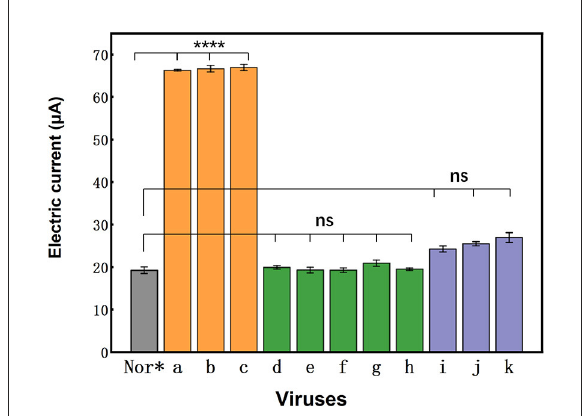
FIGURE5 Specificity of the photoelectrochemical biosensor approach to different viruses. Photocurrent responses of the universal aptasensor to 2.16 × 10 4 ffu/ml of normal NA cell (Nor*), rRC-HL (a), CVS-24 (b), GX074 (c), CSFV (d), PRRSV-5 (e), PRRSV-96 (f), PCV (g), and VSV-g (h), and photocurrent responses of the p-r-RNA aptasensor, p-w-RNA aptasensor, and p-c-RNA aptasensor to 2.16 × 10 4 ffu/ml of rRC-HL (i), CVS-24 (j), and GX074